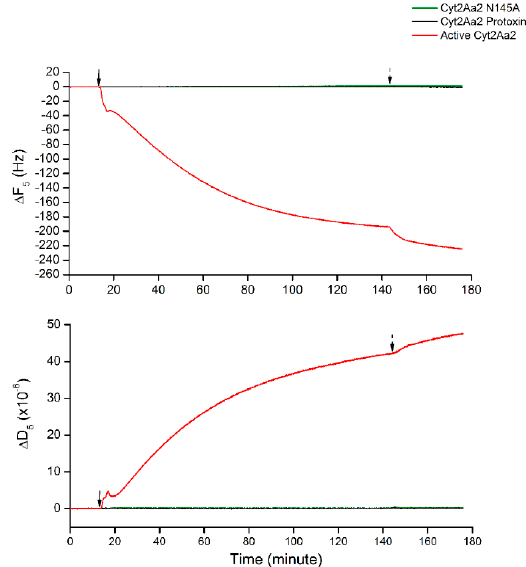
Figure 4. Negative protein binding of protease-inactivated Cyt2Aa2 and inactive Cyt2Aa2 N145A on the lipid bilayer of 5:3 (POPC:Chol) ratio. All protein solutions of 25 µg/mL were filled into QCM-D chambers, then the solution flow was paused for 2 h. The protein–lipid binding was considered by ∆ F and ∆ D changing. The solid and dash arrows indicate to points of protein injection and buffer rinsing, respectively.